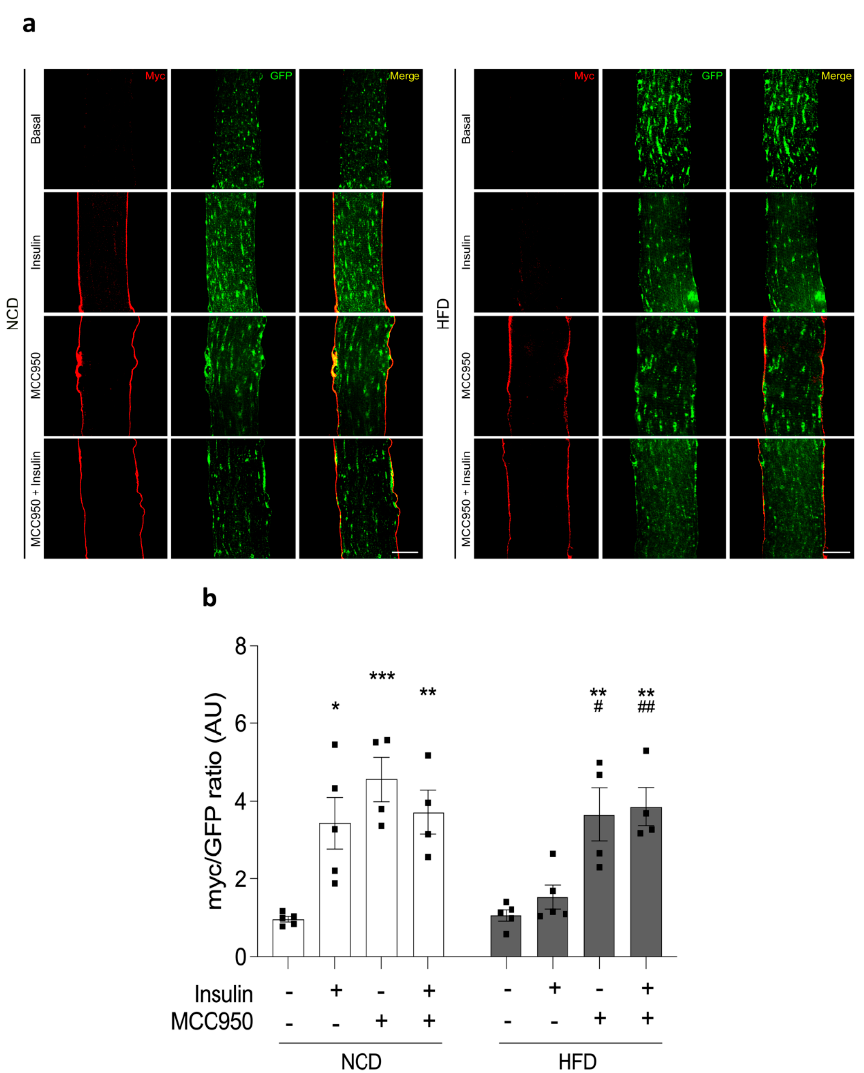
Figure 7. MCC950 improves the insulin-mediated GLUT4 myc -eGFP translocation to the cell surface. ( a ) Representative images showing GLUT4 distribution in fibers electroporated with the GLUT4 myc -eGFP (green) chimera plasmids. The fibers were isolated from NCD- or HFD-fed mice. The extracellular myc epitope (shown in red) was detected by immunofluorescence in non-permeabilized fibers treated with 100 nM insulin (20 min), 10 µ M MCC950 (overnight), or both. Scale bar: 30 µ m. ( b ) The bar graph shows the quantification of the effects presented in ( a ). Values represent the mean ± SEM ( n = 4–5 independent experiments). Statistical analysis was performed by the Kruskal–Wallis test followed by Dunn’s post-hoc test. * p < 0.05, ** p < 0.01, and *** p < 0.001 vs. the basal NCD condition, and # p < 0.05 while ## p < 0.01 vs. the basal HFD condition.